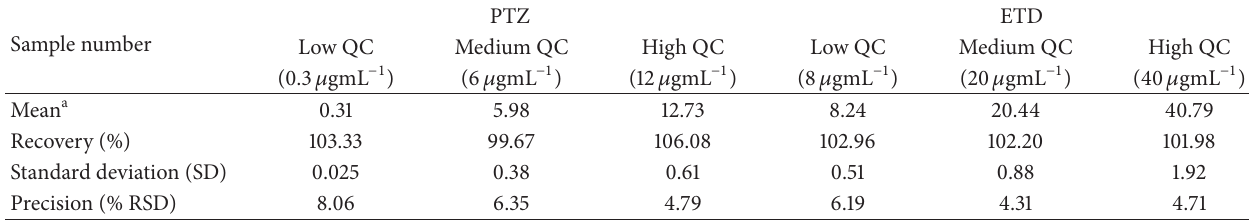
Table 5: Recovery of QC samples for determining the concentration of PTZ and ETD in